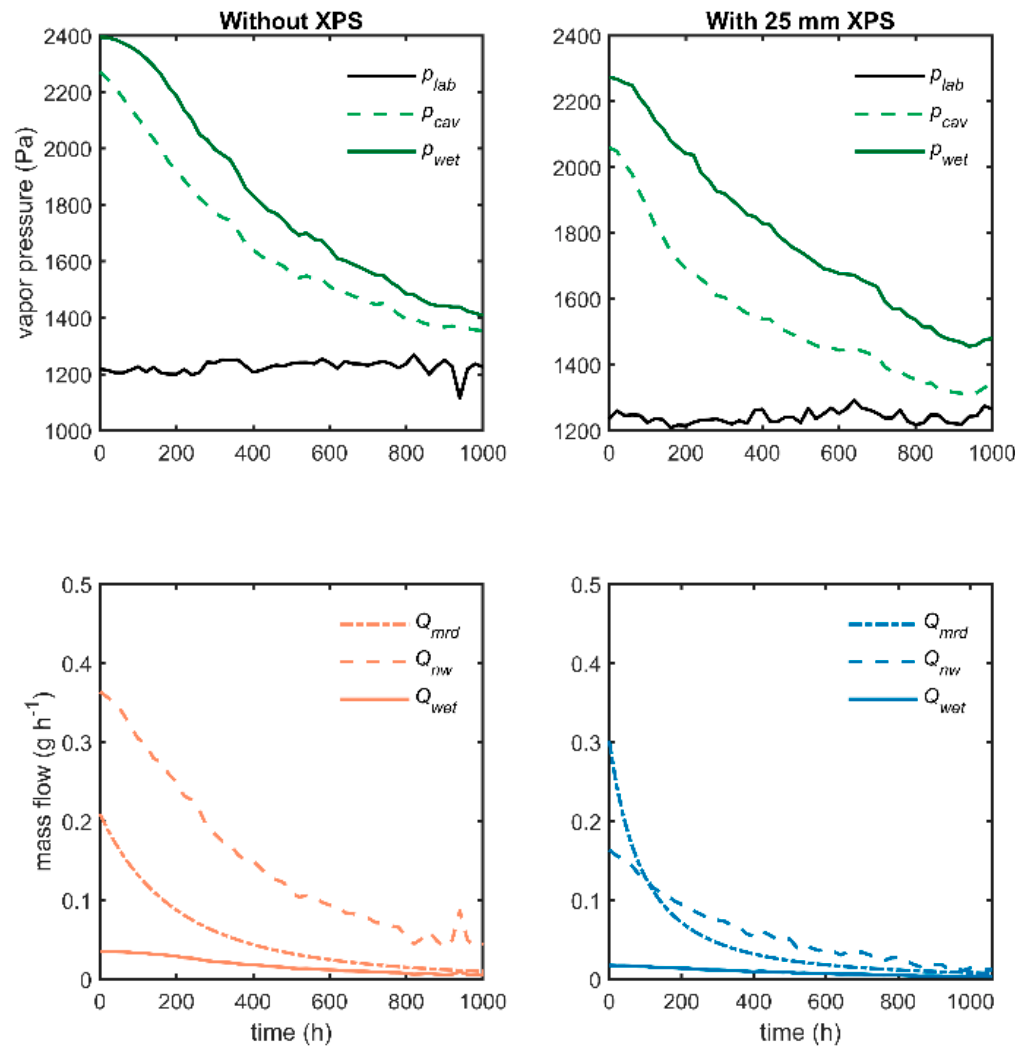
Figure 11. Vapor pressures and flows for walls with exposed framing lumber (wood, w/o XPS and wood, w/ XPS).